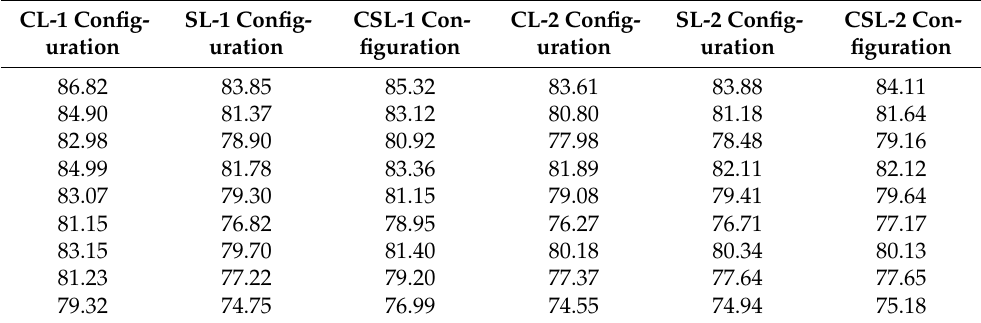
Table 7. Weight reduction percentage of the L-systems-based structures with respect to the weight of the 2D rough structure (298.2